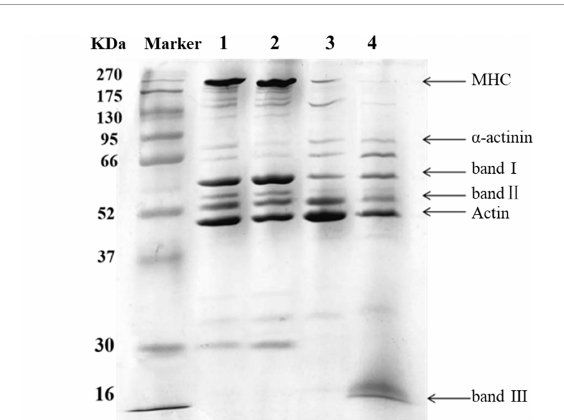
FIGURE3 SDS-PAGE of golden pompano myofibrillar protein. Lane